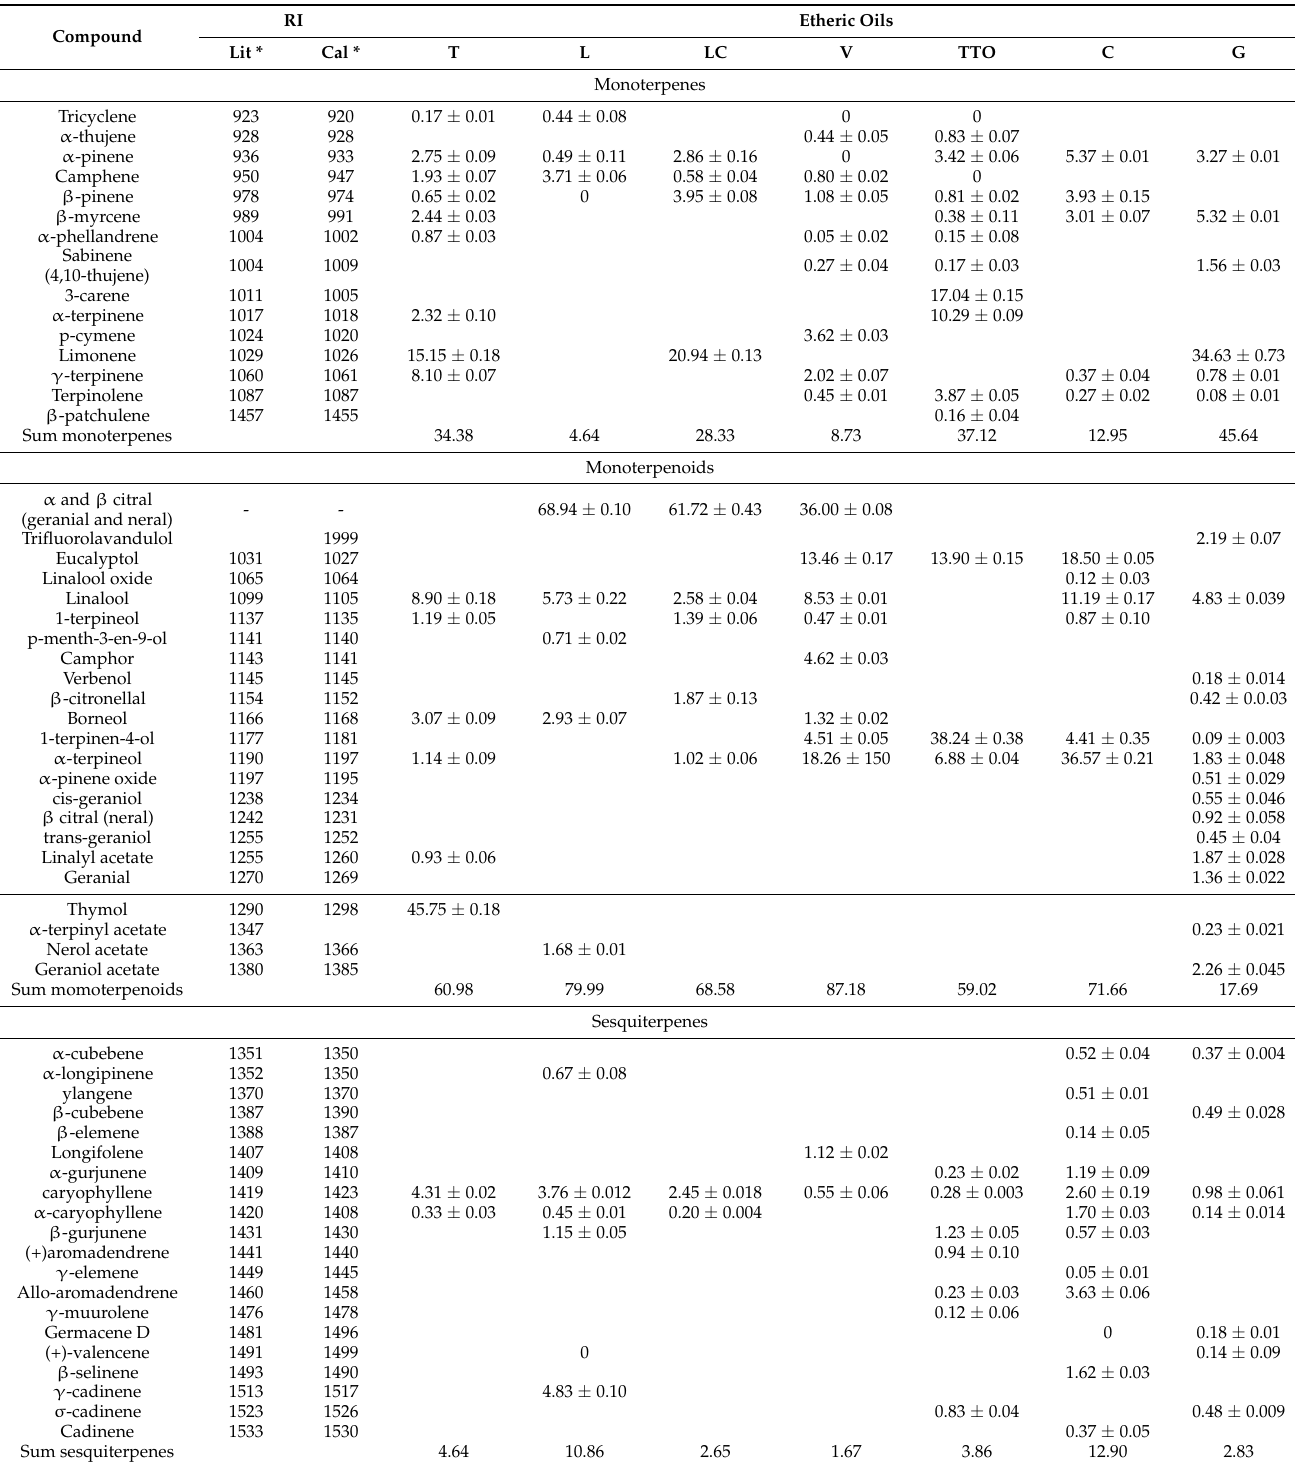
Table 5. Chemical composition of the tested essential oils in [%]: T—thyme; L—lemongrass; LC— Litsea cubeba ; V—verbena; TTO—tea tree; C—cajeput; G—grapefruit